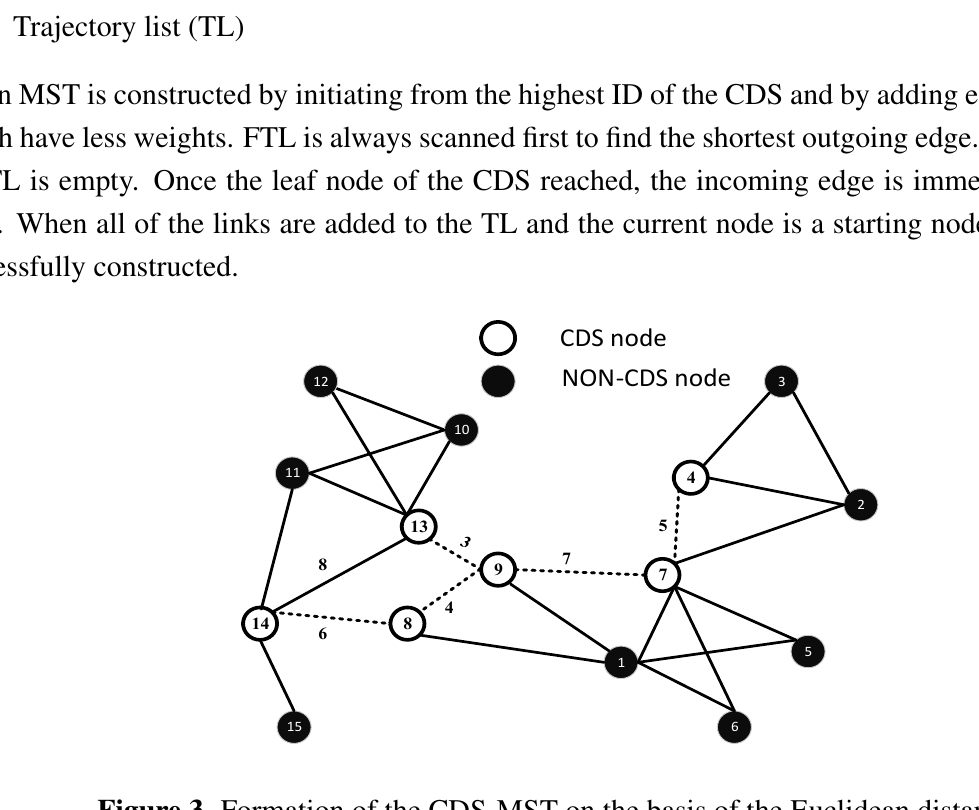
Figure 3. Formation of the CDS-MST on the basis of the Euclidean